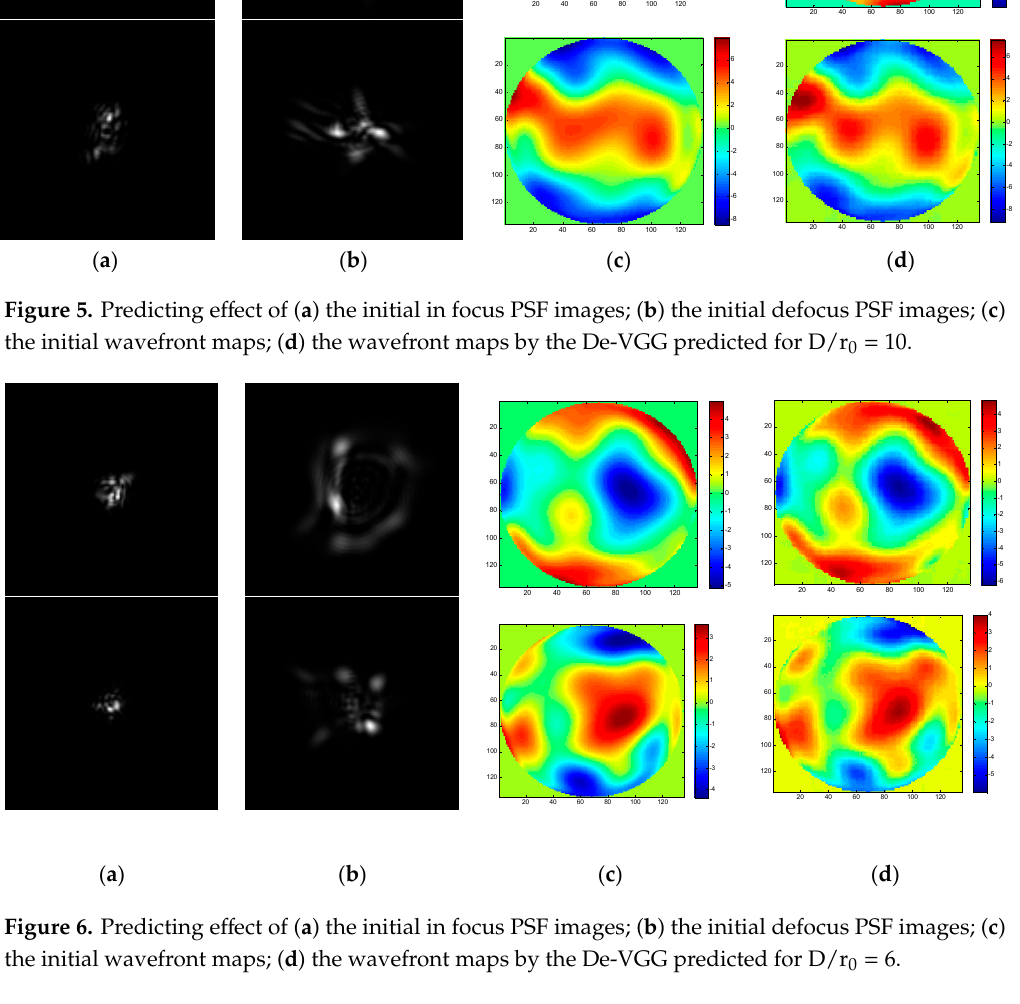
Table 1. Normalized-pixel-mean-square (NPMS) under different test sets of the reconstructed and simulated wavefront.